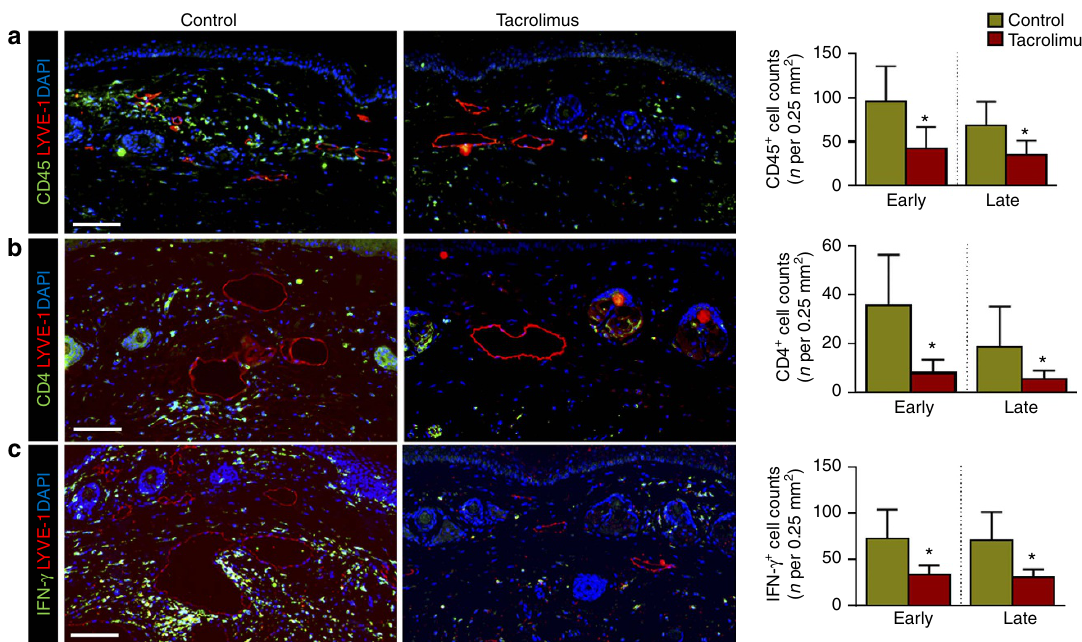
Figure 2 | Topical tacrolimus decreases inflammation after lymphatic injury. ( a – c ) Representative (cid:3) 40 images of tail tissue sections from control and topical tacrolimus-treated animals 6 weeks after surgery with immunofluorescent localization of CD45 þ ( a ), CD4 þ cells ( b ) and IFN- g þ cells ( c ). Lymphatic vessels are stained for LYVE-1 þ (red) in each figure. Quantifications of positive cell per 0.25mm 2 area (four random areas per mouse) for both early and late treatments are shown to the right of each figure ( P o 0.001 for all; n ¼ 8/group). Experiments were repeated two to three times. All data represent mean ± s.d. with P r 0.05 considered as significant. Data analysed by two-tailed Student’s t -test. Scale bars, 100 m